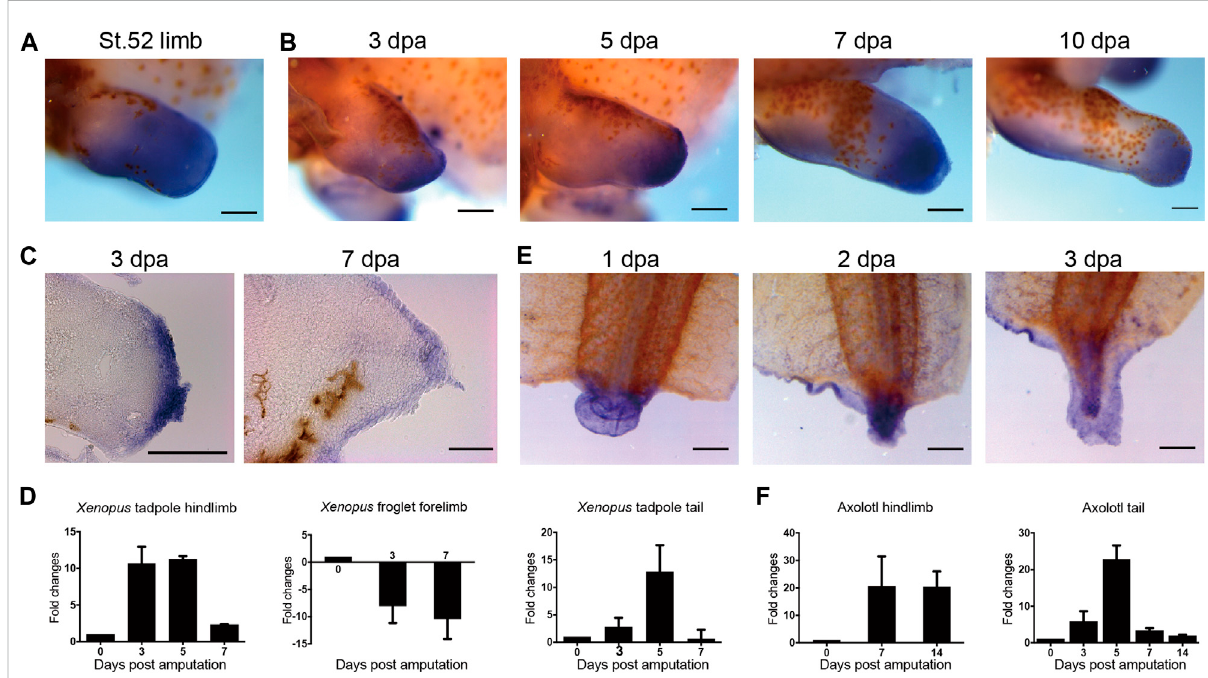
FIGURE 1 Expression of evi5 during limb and tail regeneration in Xenopus and axolotl. (A) Detection of evi5 mRNA in NF stage 52 tadpole hindlimb by whole mount in situ hybridization (WISH). (B) Detection of evi5 mRNA in stage 52 tadpole hindlimb at 3,5,7 and 10 days post amputation (dpa). (C) Sagittal section of3and 7dpa WISH specimens showing evi5 expressioninwound epithelium andblastemaregion ofregenerating Xenopus tadpole hindlimb. (D) RT-PCR analysis of evi5 in the NF stage 52 tadpole limb, froglet forelimb and tadpole tail. (E) WISH analysis of evi5 mRNA expression during Xenopus tadpole tail regeneration. (F) RT-PCR analysis of Evi5 in the regenerating axolotl limb and tail. Scale bars represent 500 μ m in (A – B,E) and 3 dpa specimen in (C) , 50 μ m in 7 dpa specimen shown in (C) . Data shown in (D,F) are mean with standard derivations, from 3 independent experiments, all with signi fi cant differences ( p < 0.05) analyzed with one-way ANOVA